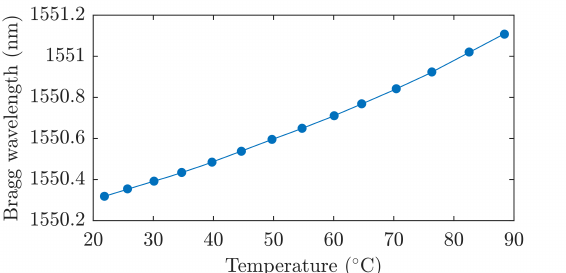
Figure 5. The dependence of Bragg wavelength on the temperature during the temperature loading in the temperature